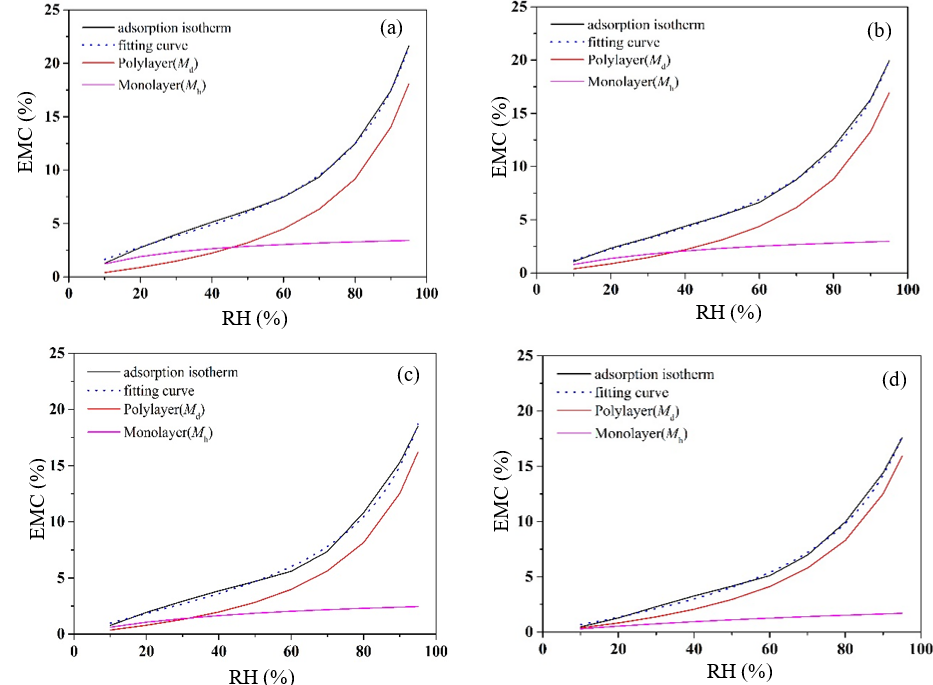
Figure 6. Monolayer and polylayer water determined by the H-H model and best fit line of sum of monolayer and polylayer adsorption isotherm by adsorption isotherm data. Control LW ( a ), 180 L ( b ), 200 L ( c ), 220 L ( d ).